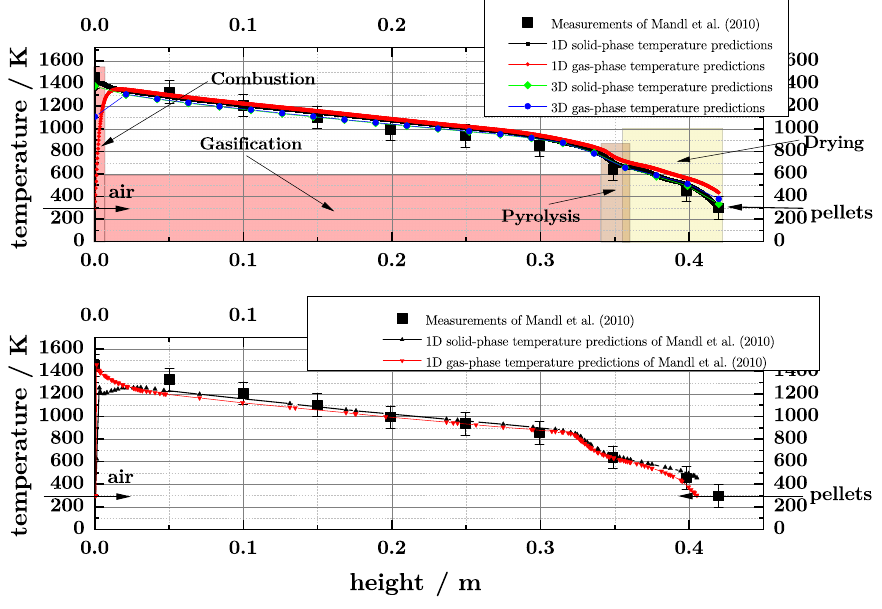
Figure 6. Comparison of the calculated and measured temperatures [24]. The error bars show an er- ror range of 50 K. Plotted 3D temperatures are averaged over gasifier diameter. ( Top ) our predictions; ( Bottom ) Mandl et al. [24]